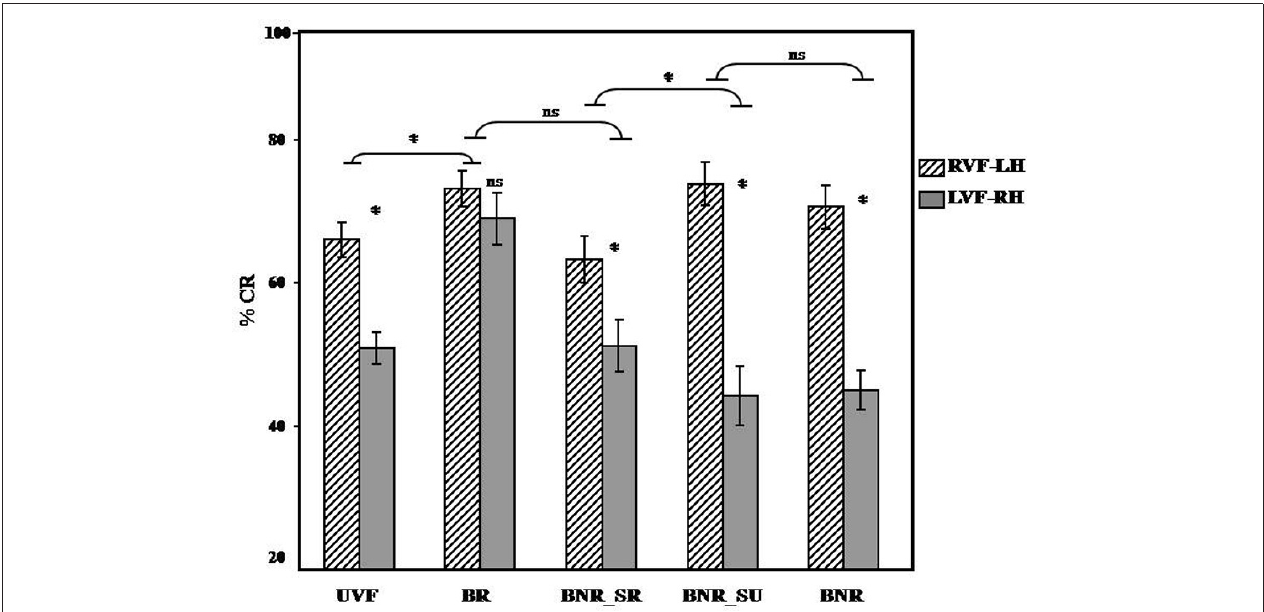
FIGURE 4 | Visual hemi-field and experimental condition interaction: illustrates in terms of accuracy the significant interaction between the visual hemi-field of presentation and the experimental condition for UVF vs. BR and BNR_SR vs. BNR_SU. Abbreviations: UVF, unilateral visual